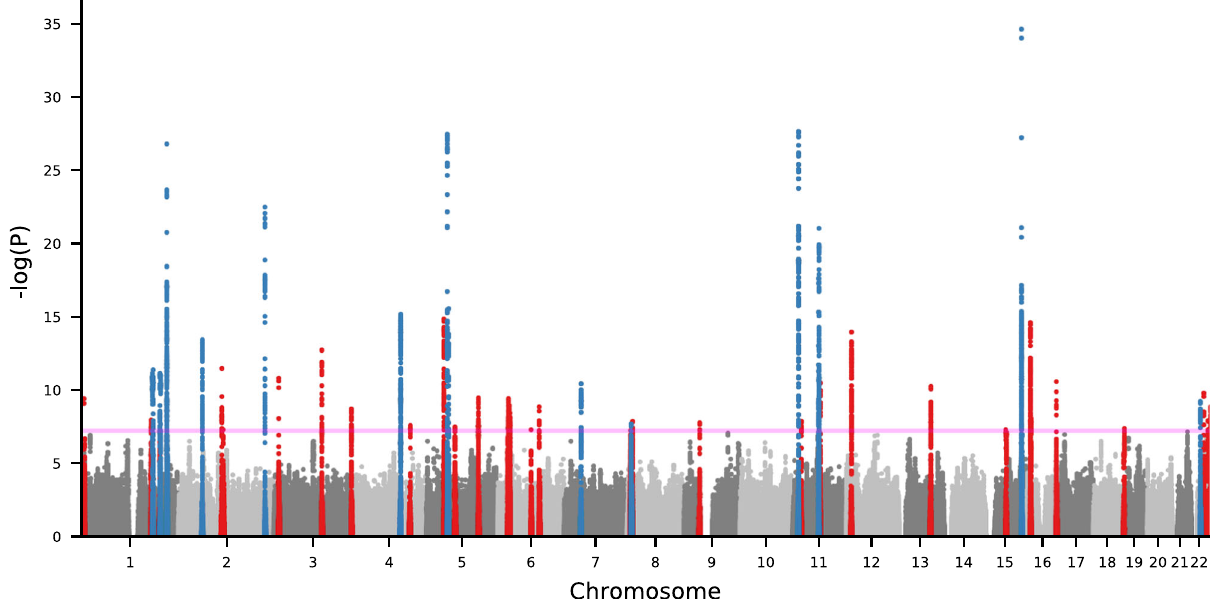
Fig. 1 Manhattan plot showing genome-wide signi fi cant loci associated with acne (20,165 cases, 595,231 controls). Axes contain a point for each genetic variant passing QC ordered by chromosome and base position on the x -axis, with − log10( P -value) of association (two-sided Z -test, not adjusted for multiple comparisons) plotted on the y-axis. Blue indicates variants within previously established loci and red indicates variants within novel loci. Pink line indicates genome-wide signi fi cance threshold ( P = 5 × 10 − 8